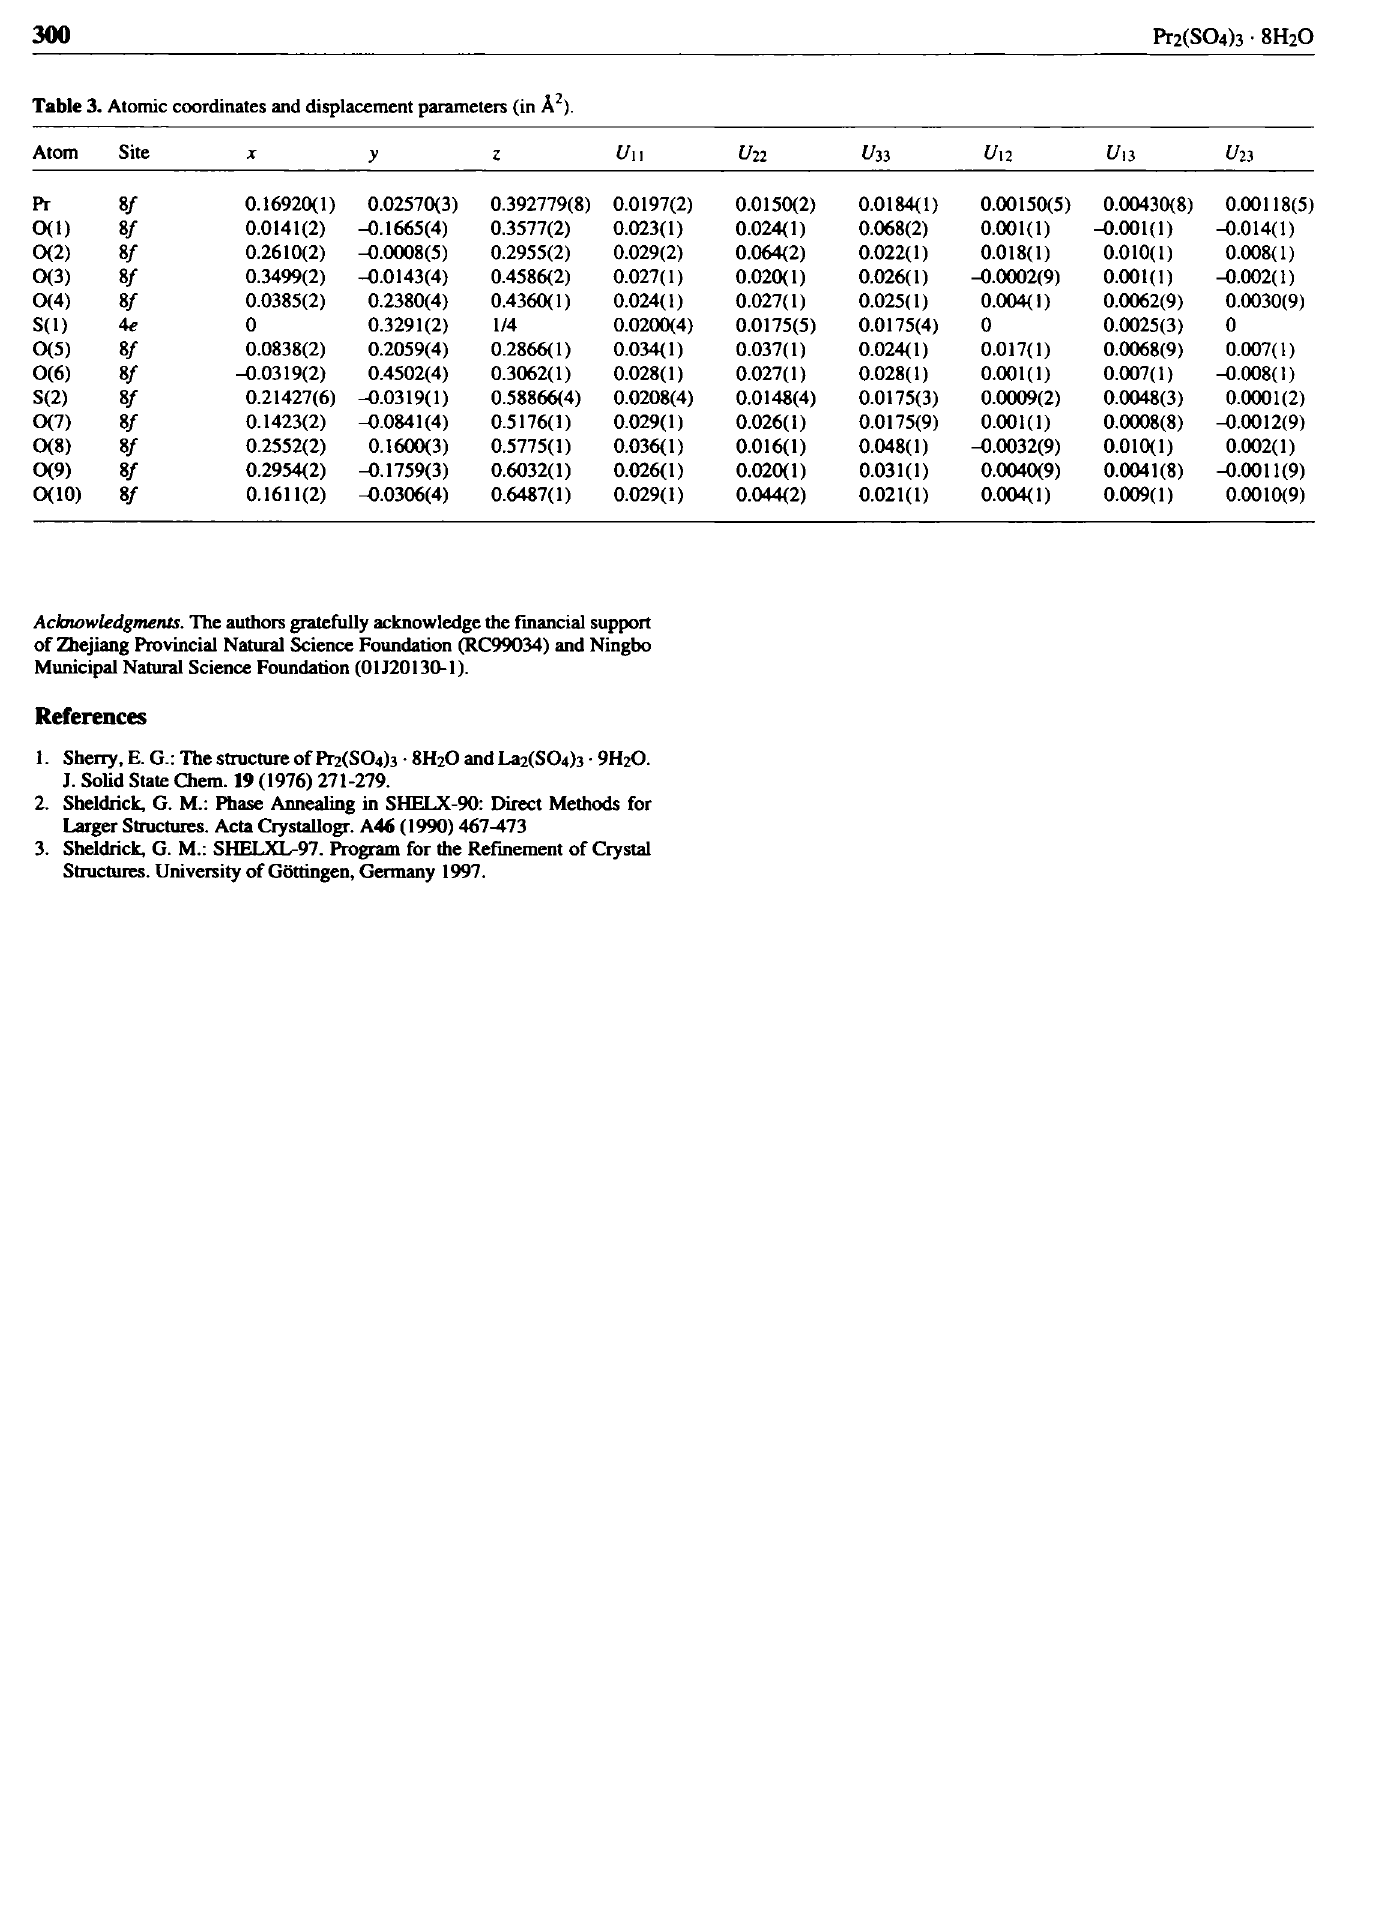
Table 3. Atomic coordinates and displacement parameters (in Â 2